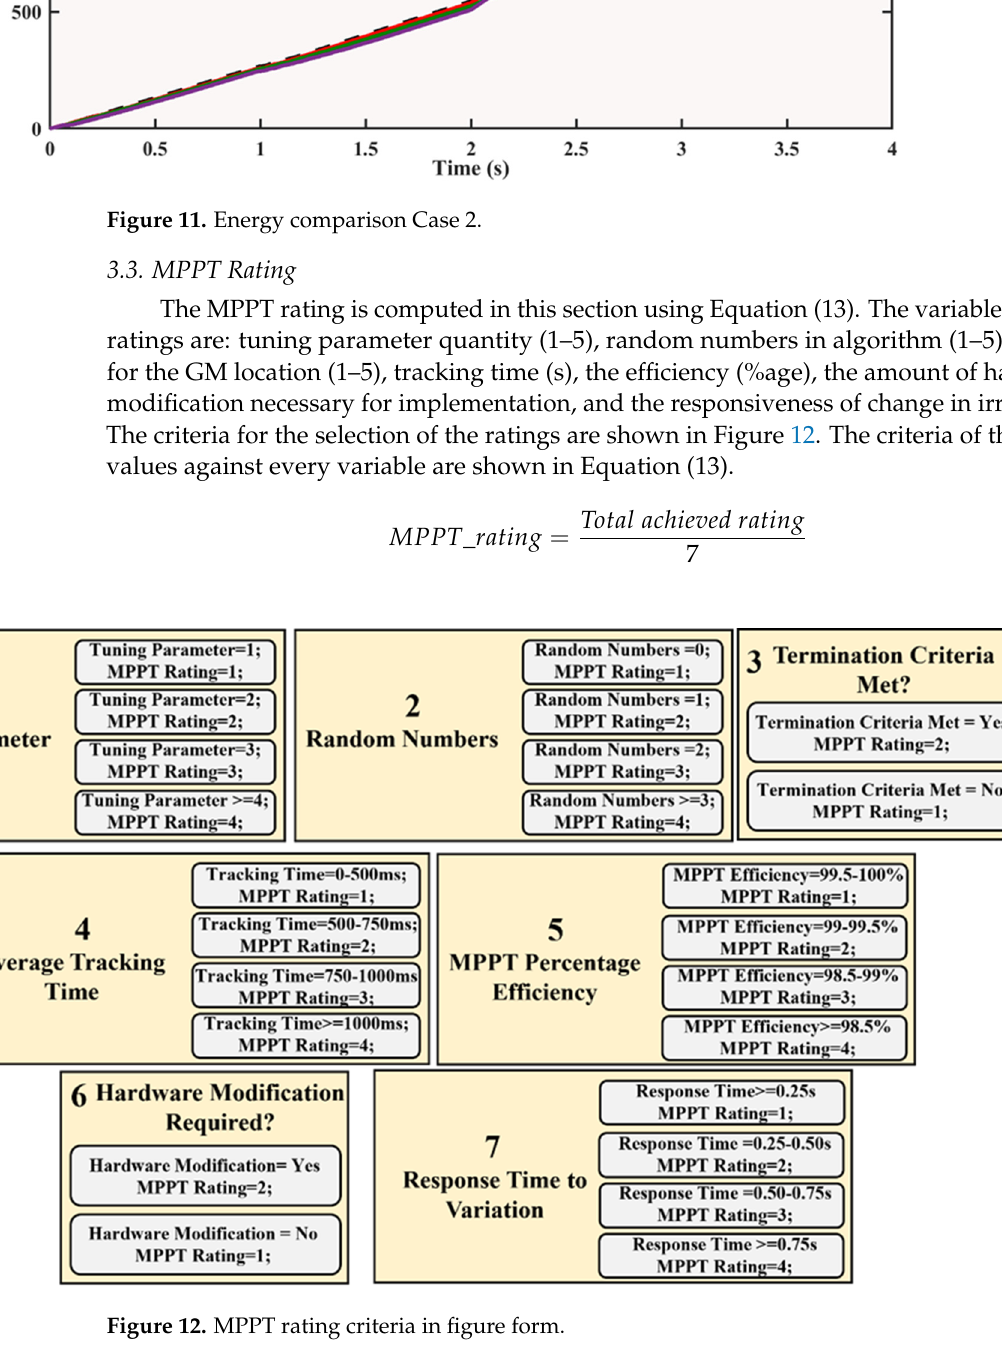
Figure 11. Energy comparison Case 2.